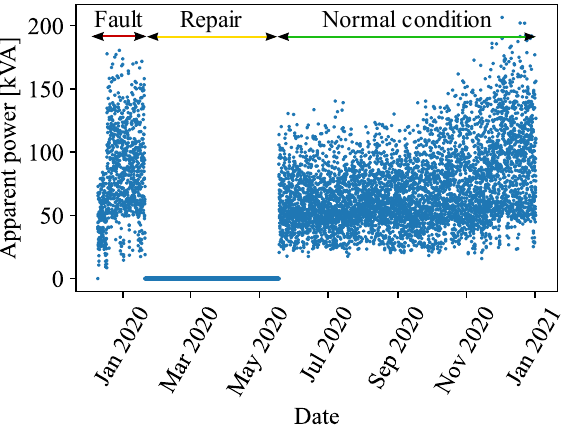
Figure 9. Absolute load of the transformer. The faulty on-load tap changer leads to an unsymmetrical voltage output of the transformer and increased vibration. Figure 10 shows one of the malfunctioning parameters during the fault: the unsymmetrical voltage. The figure displays the transformer voltage of phase L1, phase L2, and phase L2 for the period under review. During the fault, the voltage of phases L1, L2, and L3 are not symmetrical and have a mean voltage of 233.2 V (L1-N), 230.8 V (L2-N), and 227.8 V (L3-N), respectively. After the repair, the phase imbalance is drastically reduced. The mean voltage is 230.8 V (L1-N), 231.3 V (L2-N), and 231.9 V (L3-N), respectively.